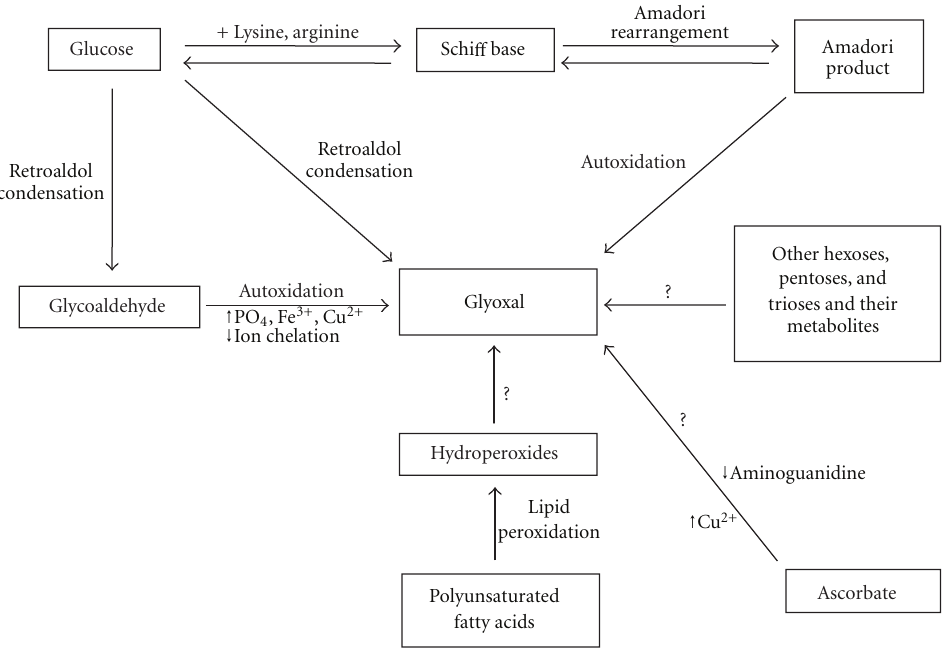
Figure 1: Sources of